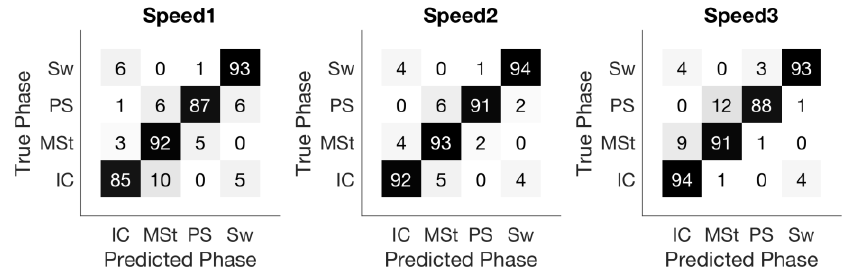
Figure 4. Confusion matrix of sample-based accuracy in different speeds. Misclassification occurs mostly during phase transitions.